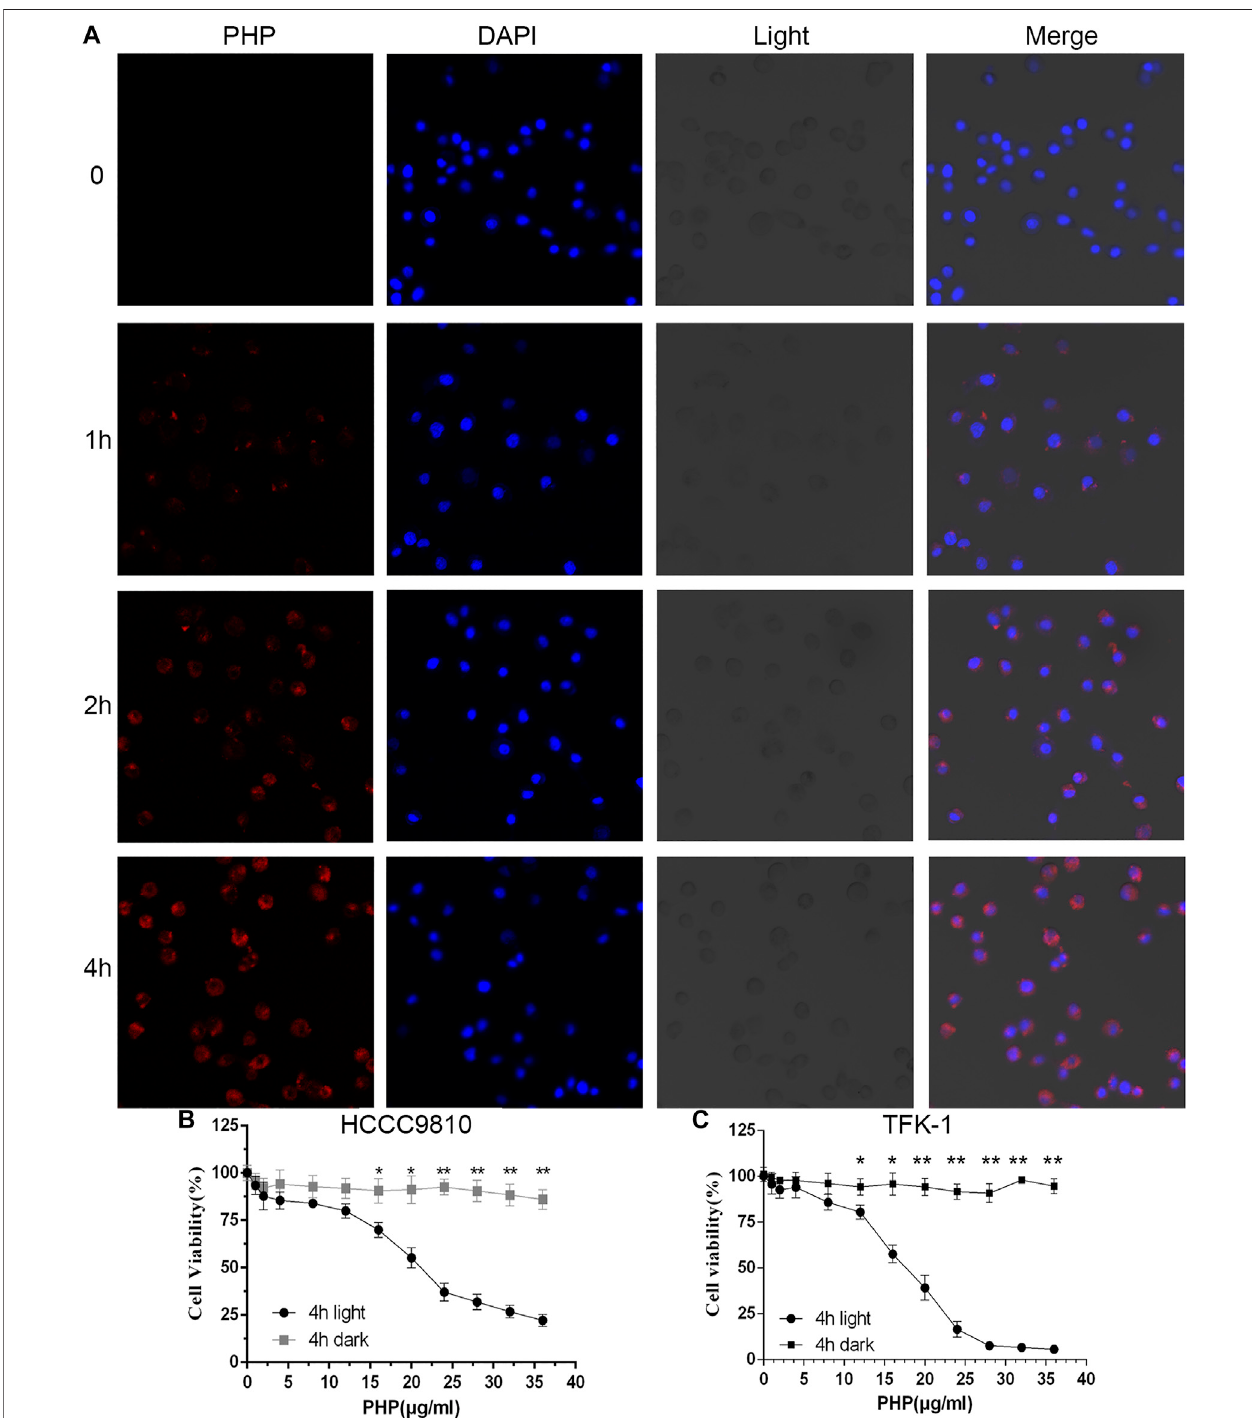
FIGURE2| PhototoxicityofCCAcells. (A) RepresentativeCLSMimagesdemonstratingthecellularuptakeofPHP(red)withHCCC-9810cellsafterincubationwith PHP for0 – 4 hat37 ° C.Originalmagni fi cation: 400 × . (B,C) Relative cellviabilityofPHP-treatedHCCC-9810andTFK-1cellsinthedarkorwithlightirradiation at630 nm (10 J/cm 2 ). Data are shown as mean ± SEM ( n (cid:2) 3). * p < 0.05, ** p < 0.01.